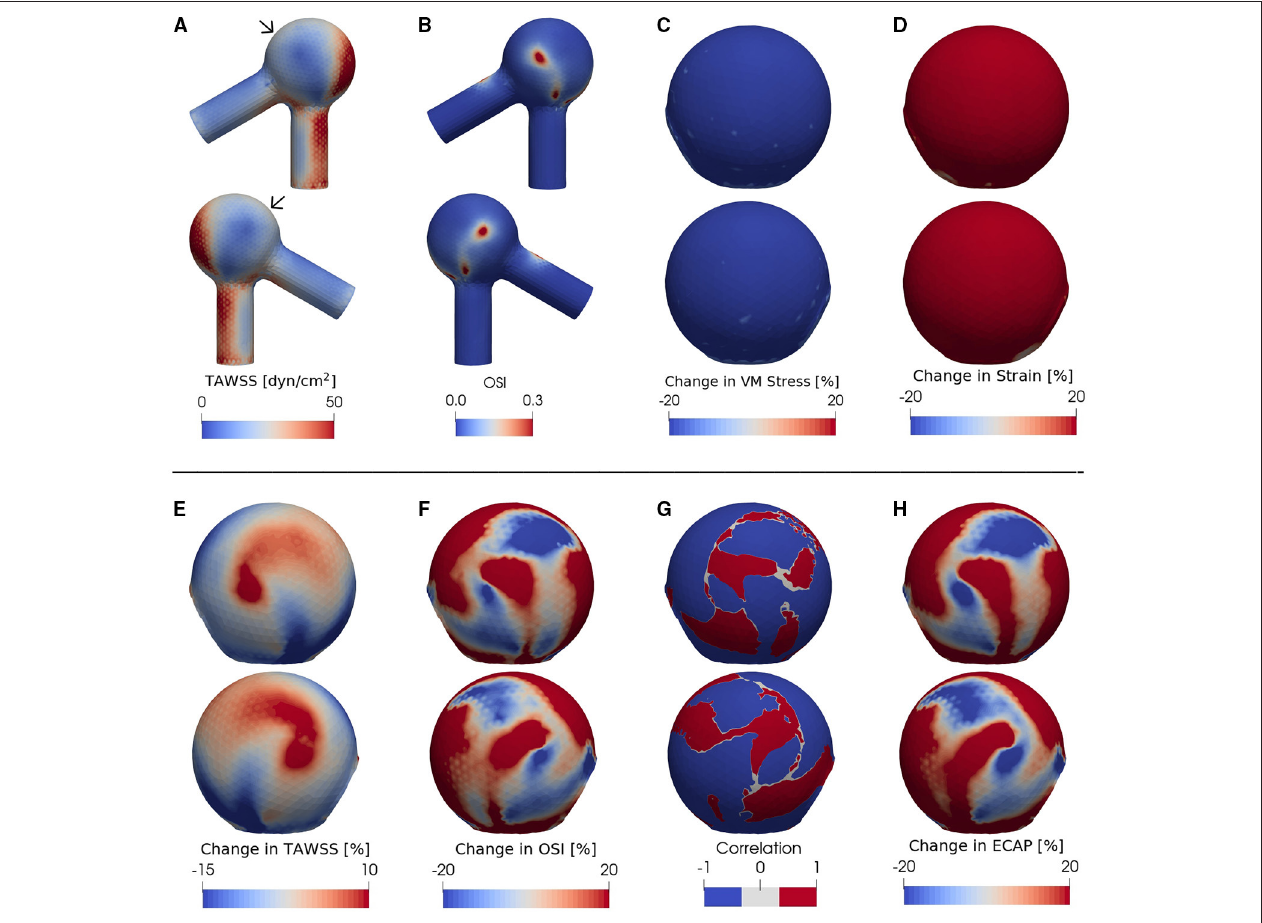
FIGURE 3 | (A) TAWSS and (B) OSI fields in the presence of degradation using an idealized aneurysm model. Relative percentage change (Equation 4) of (C) Von Mises stress, (D) strain magnitude, (E) TAWSS and (F) OSI between non-degraded and degraded cases; the blue (red) color indicates a decrease (increase) of each metric upon tissue degradation. Panel (G) illustrates the correlation function between the data shown in the panels (E,F) , calculated via Equation (5) and digitized to –1 or 1 for all data points with a magnitude > 5 % . The region with blue color corresponds to an inverse effect of degradation on TAWSS as opposed to OSI: In places where TAWSS decreases due to degradation, OSI increases and vice versa. A positive correlation, on the other hand, is represented by a red color in (G) . (H) shows the relative change of ECAP upon degradation. In all cases, the pressure ranges from 90 (diastole) to 160 mmHg (systole) and T = 0.6 s. For each case investigated, the locations of low-WSS (indicated by arrows) remain nearly intact during a full cardiac cycle. In order to better visualize the data, the second (fourth) row shows the same simulated data as in the first (third) row but after rotating the aneurysm dome by an angle of π around the polar axis. In (C–H) we show only the aneurysm region since the degradation model is applied only on the aneurysm